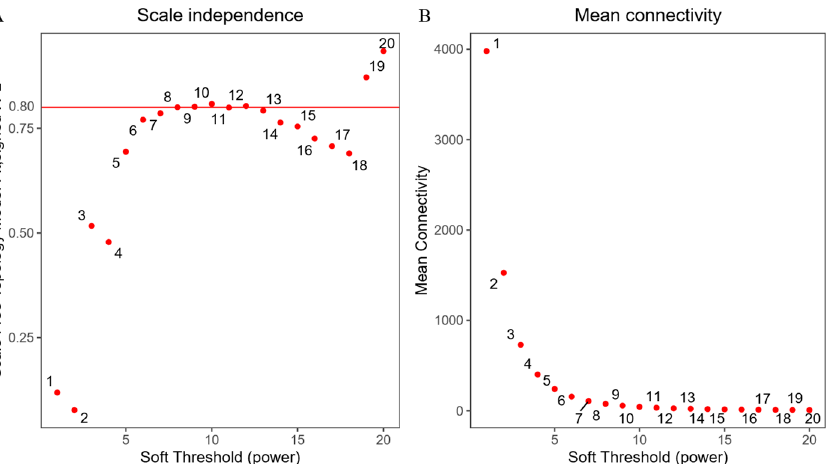
Figure 1. Determination of soft threshold. ( A ) Ordinate indicates correspondence between β Value and the goodness of fit R 2 between the adjacency matrix after transforming the scale-free network assumption. When the soft threshold is 8, R 2 is greater than 0.8. ( B ) The ordinate represents the average connectivity of each node in the network, determined by the corresponding β the adjacency matrix representation after value conversion.